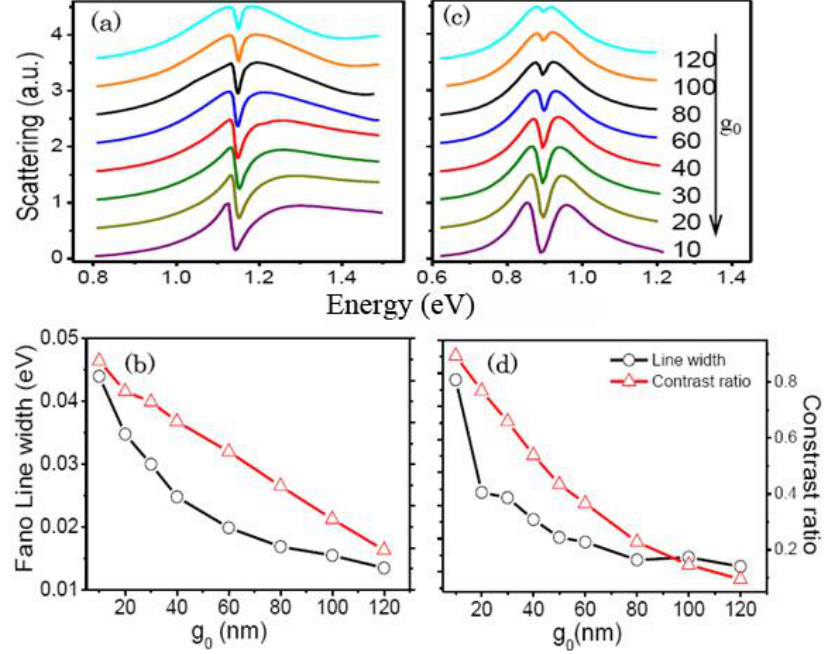
Figure 6. ( a ) The scattering spectra of the RCSRD and ( b ) the Fano linewidth and contrast ratio as functions of the gap width g for the gap g of 10 nm and the rod length a of 145 nm; 0 ( c – d ) The same information for the g of 5 nm and the rod length a of 340